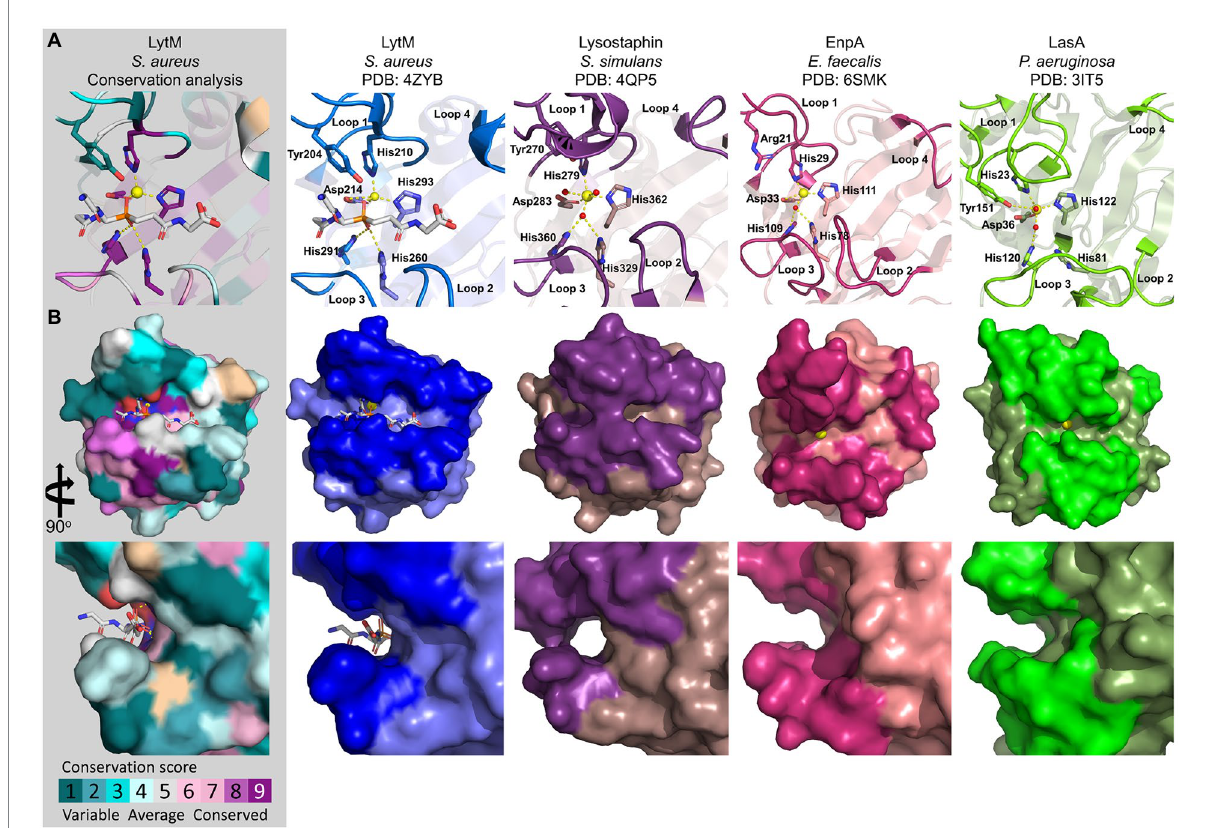
FIGURE 3 Crystal structures of representative M23 metallopeptidases: LytM (blue; 4ZYB), Lysostaphin (violet; 4QPB), EnpA (magenta; 6SMK), and LasA (green, 3IT5). The M23 peptidases sequence conservation score was calculated in the ConSurf server and is displayed on LytM surface (PDB ID: 4ZYB; Landau et al., 2005). (A) Active sites and loop architectures are represented as cartoons. The active site residues are depicted as bold sticks and labelled accordingly. The zinc ion is shown as a yellow sphere. The LytM was crystallized in the presence of tetraglycine phosphinate, and the resulting complex served as a model for the substrate-binding mechanism. (B) The top view (upper panel) and site-zoomed view (bottom panel) of the corresponding surface represent the M23